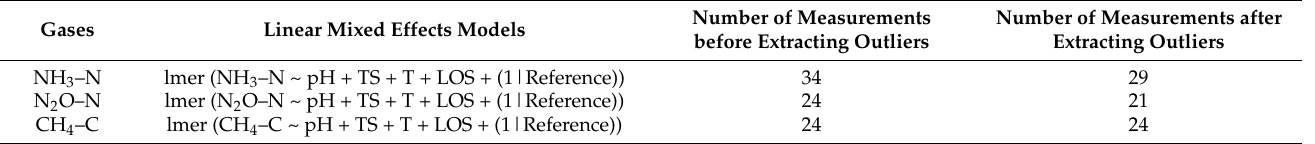
Table 2. The composition of fitted models to investigate the effects of slurry pH, TS content, T and LOS on gas emissions from dairy slurry storage. Gases Linear Mixed Effects Models